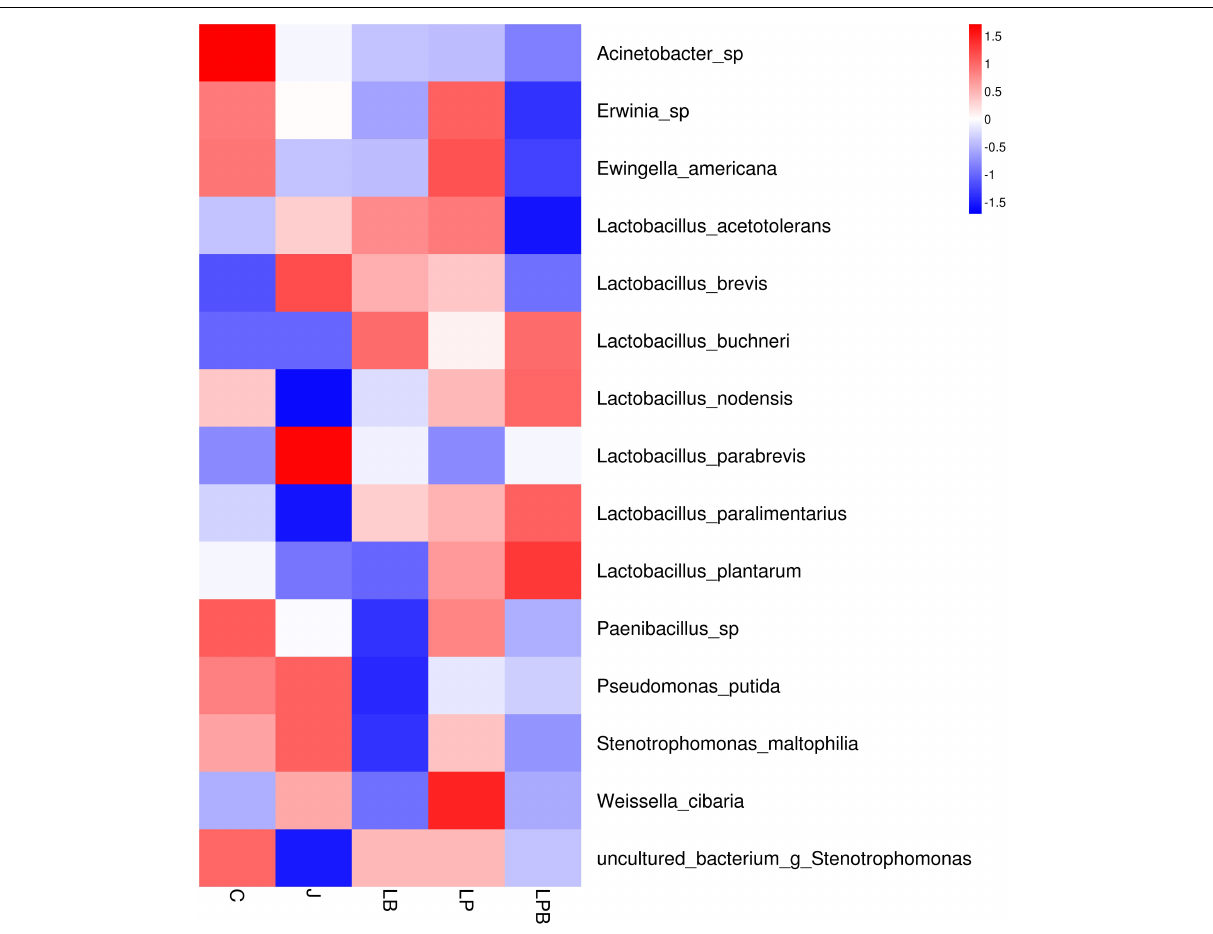
FIGURE 6 | Heatmap of prominent bacterial species (15 most abundant genera) for alfalfa mixed silage. C, control; J, pre-fermented juice-treated silage; LP, L. plantarum -treated silage; LB, L. buchneri -treated silage; LPB, L. plantarum L. buchneri- treated